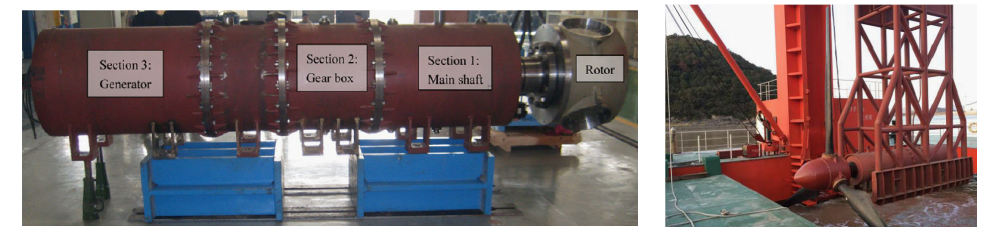
Figure 19. A 60 kW semi-direct-drive horizontal-axis generator set. Reproduced from [53,56], Else- vier.